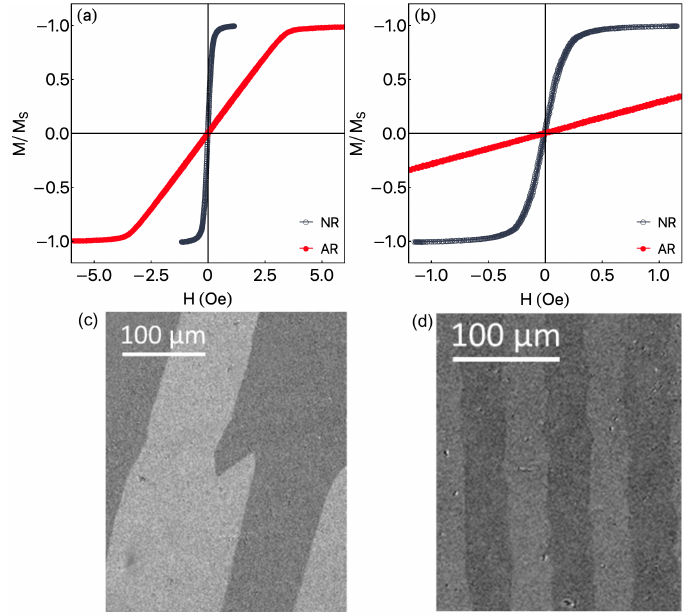
Figure 3. ( a ) Inductive hysteresis loops of amorphous Fe 3 Co 67 Cr 3 Si 15 B 12 ribbons of 35 mm lengths in initial state NR and after stress-annealing AR for the magnetic field applied along the long axis of the ribbon. ( b ) Detailed view of the curves for a small magnetic field range. ( c ) Magnetic domains image for near zero fields for NR ribbon, in which the long axis of the ribbon is vertical. ( d ) Magnetic domains image for AR ribbon, in which the long axis of the ribbon is